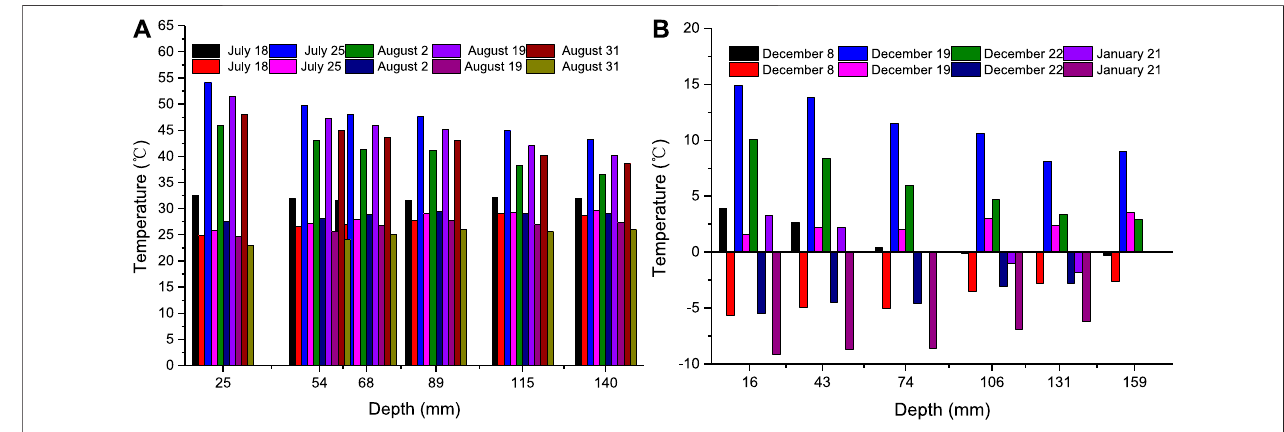
FIGURE 10 | Temperature distribution of asphalt